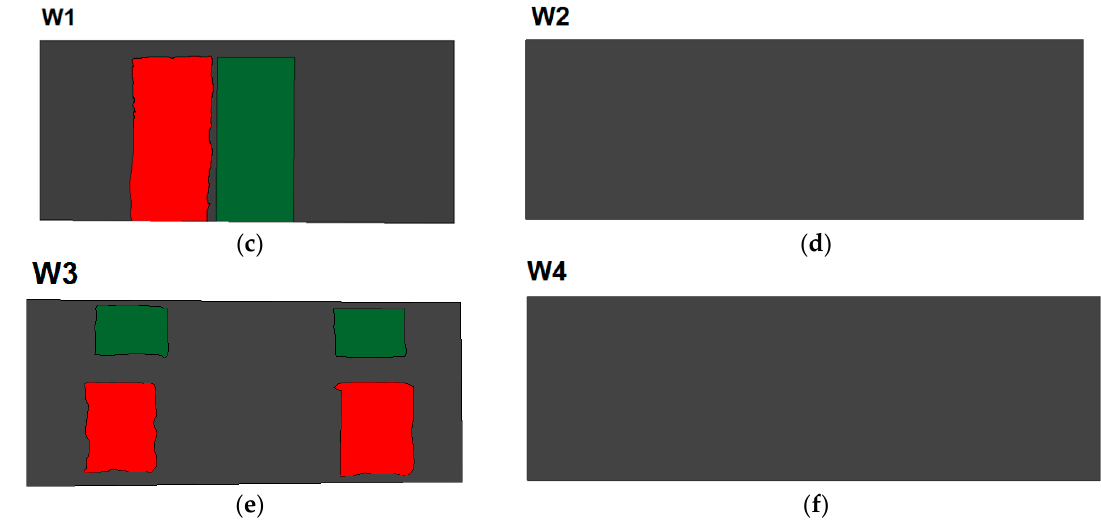
Figure 8. Reconstruction of openings: ( a ) position P 1 of the MLS sensor used to compute the occupancy map for Room 1; ( b ) segmented point cloud for Room 1 (ceiling is removed to look into the room); and ( c – f ) occupancy maps generated for the four walls in Room 1 (in gray—occupied cells, in red—occluded cells, and in green—openings).